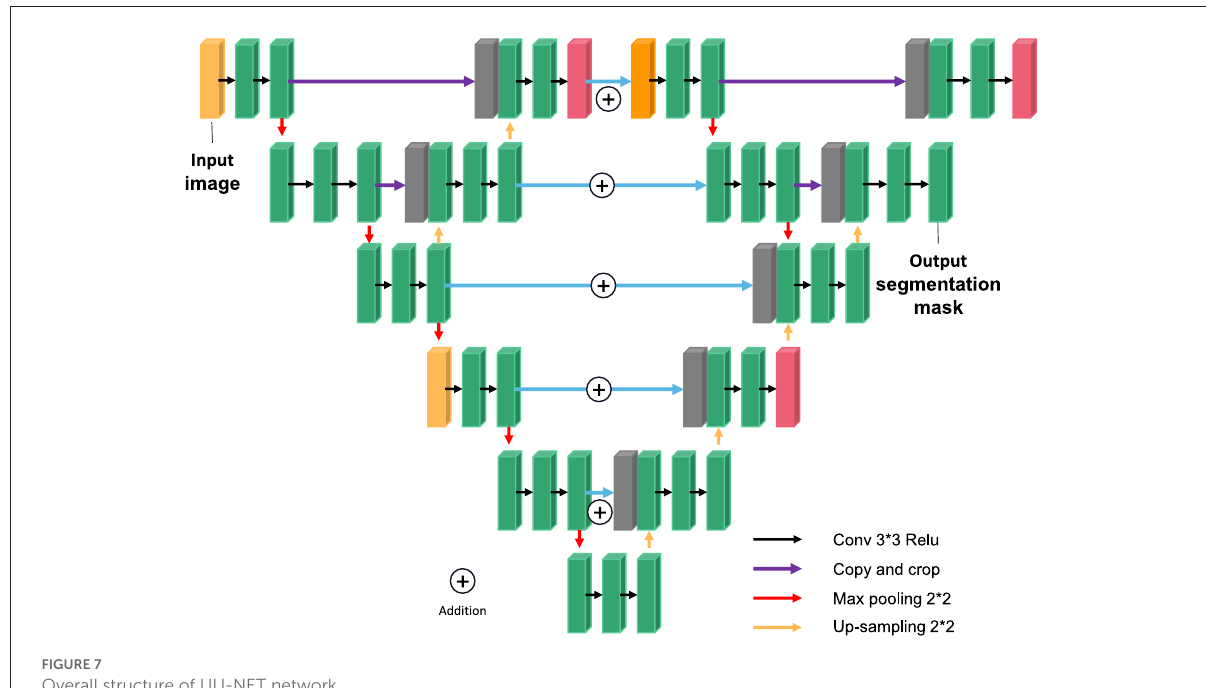
FIGURE7 Overall structure of UU-NET